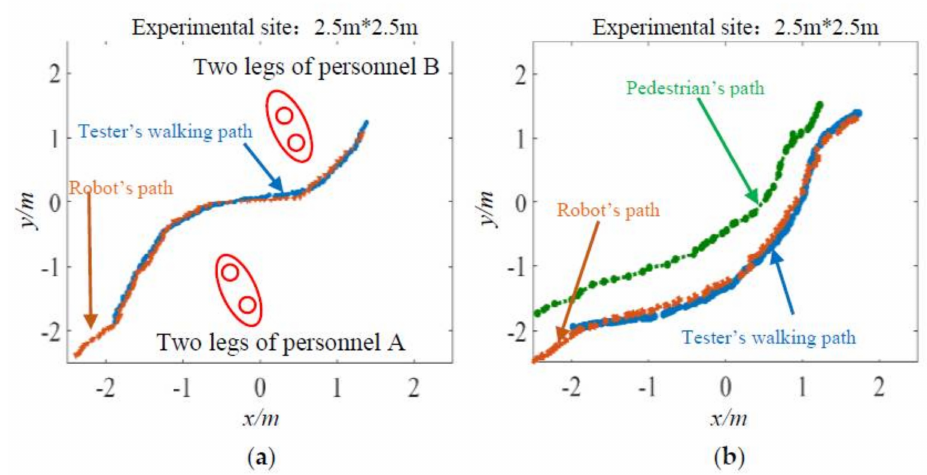
Figure 11. The trajectories of the robot and the tester in the path-tracking experiment. ( a ) Path- tracking experiment when passing through two standing personnel. ( b ) Path-tracking experiment when there are pedestrians.